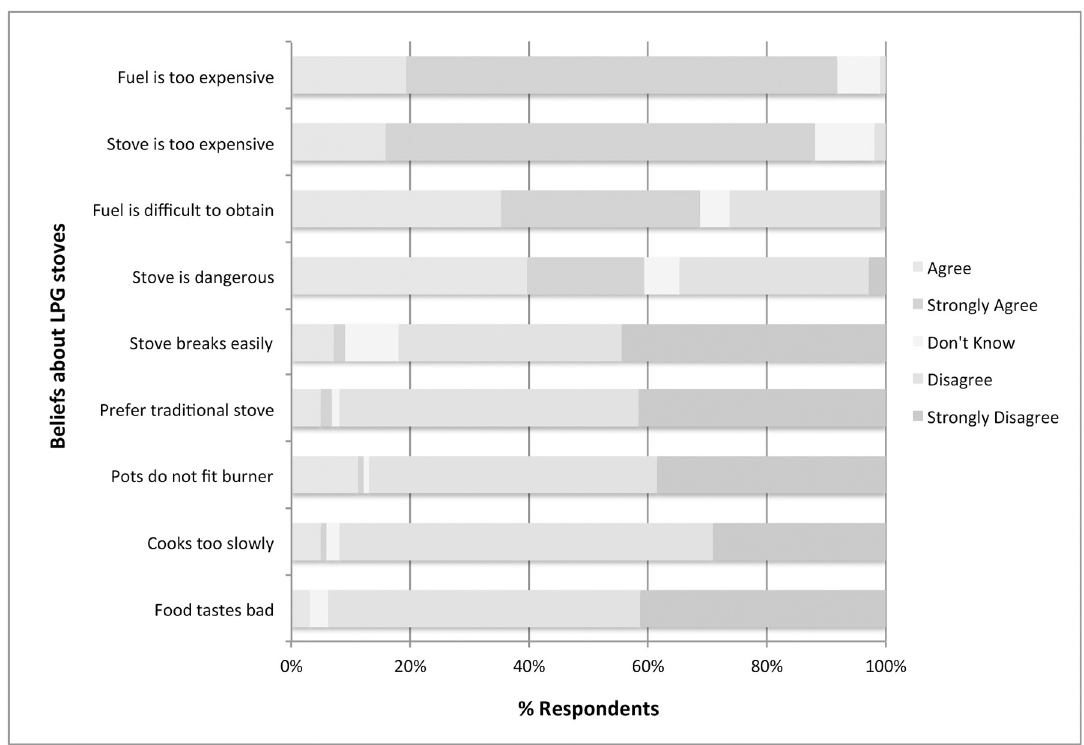
Fig 5. Likert scale presentation of perceptions of liquid propane gas stoves